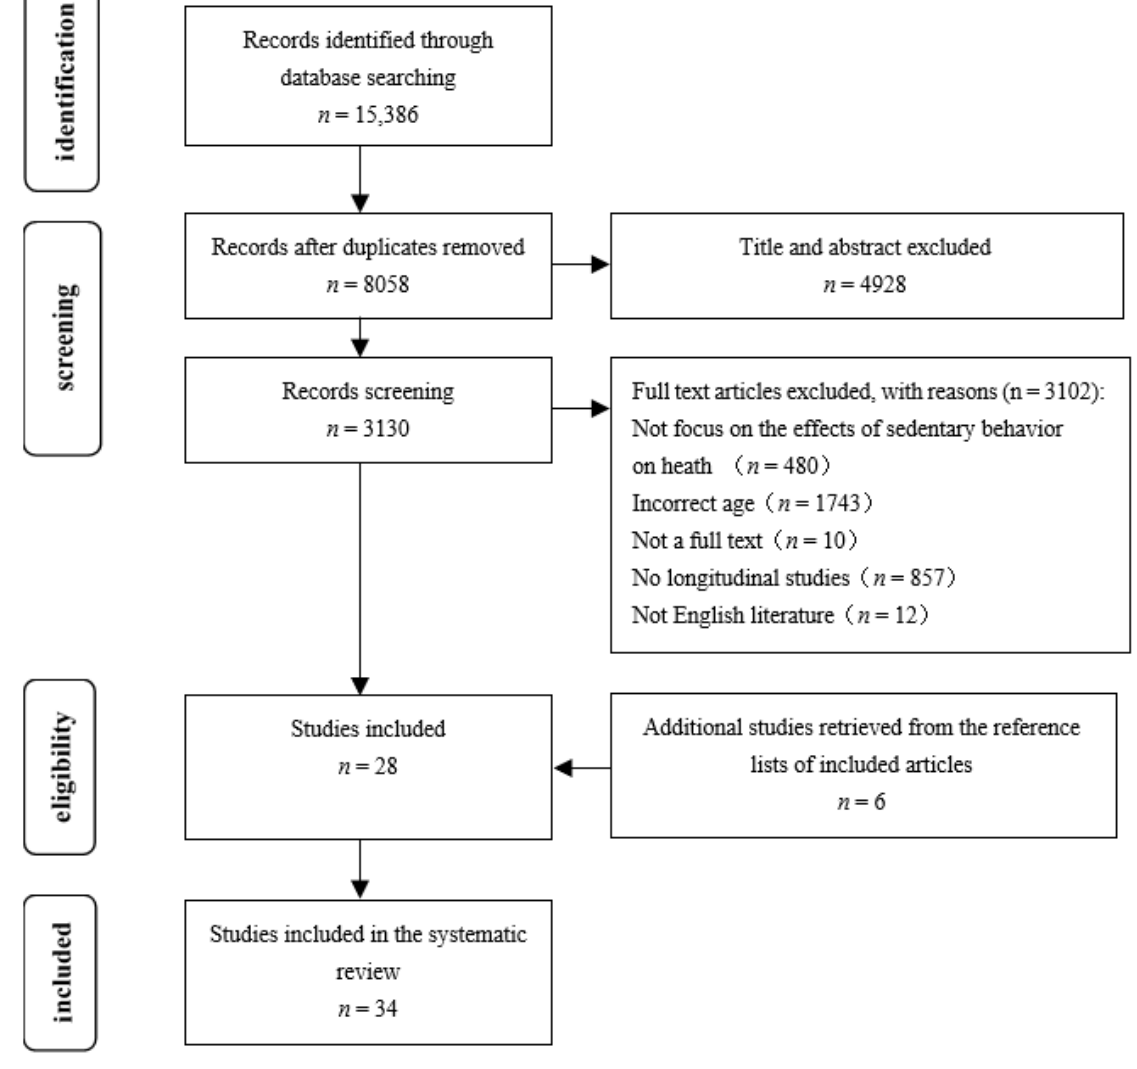
Figure 1. The flow diagram of the study selection process.